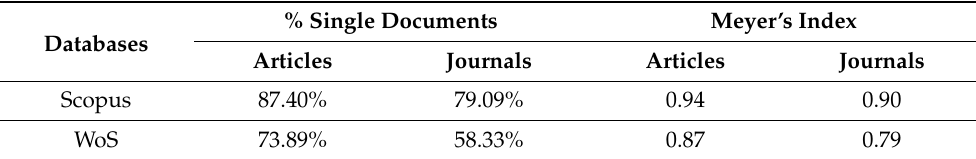
Table 4. Singularity of the